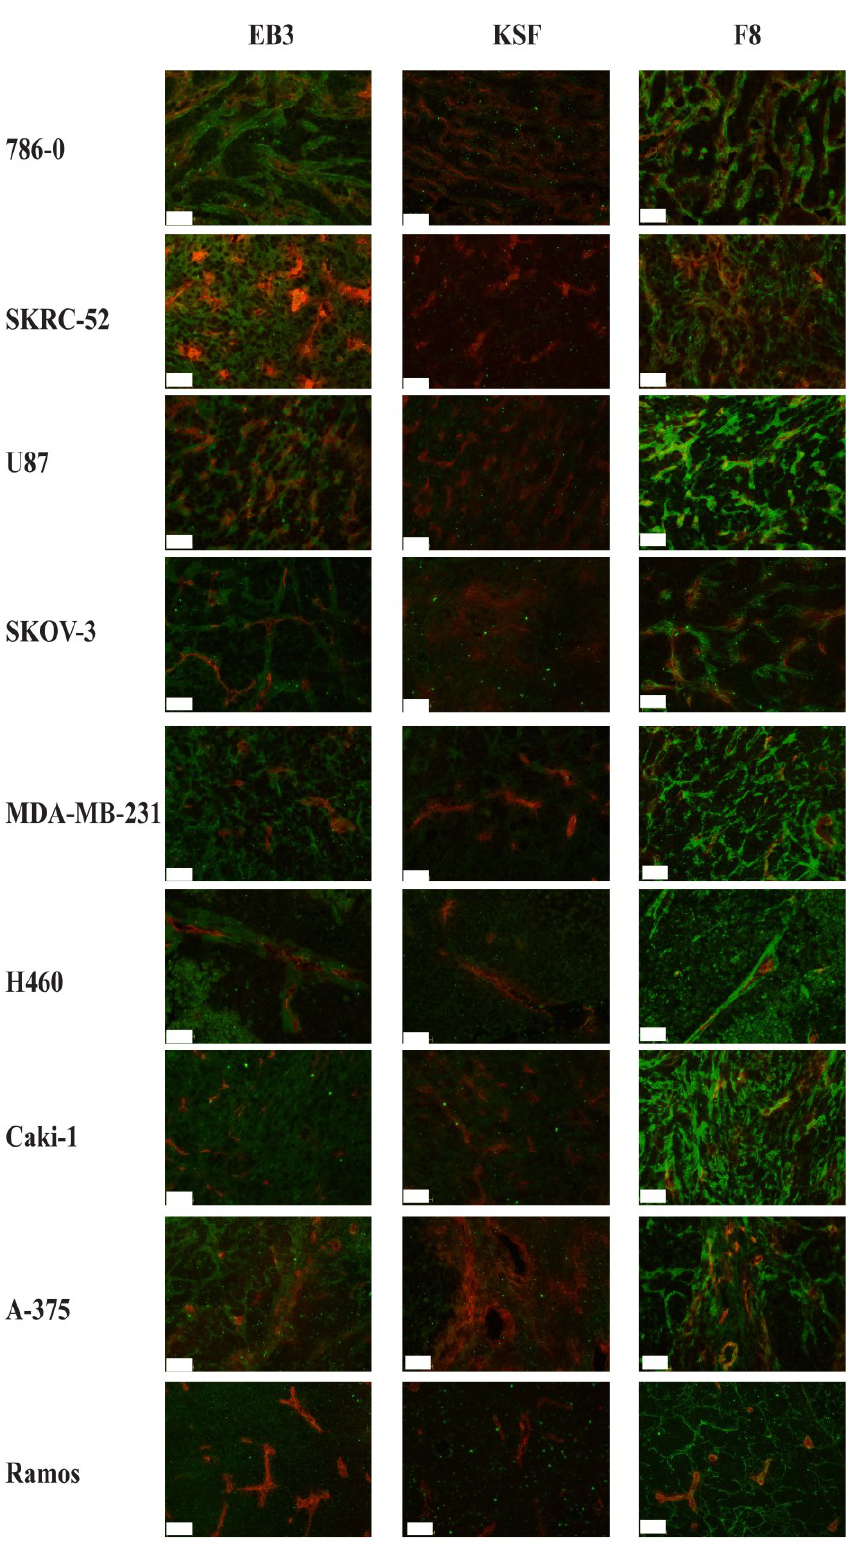
Figure 4. Immunofluorescence staining of human tumors xenografted in nude mice using SIP(KSF), SIP(EB3), SIP(F8) and anti-CD31 antibody. SIP antibodies are shown in green as they were detected using anti-human-IgE IgG antibody, which was then detected by Alexa Fluor 488 goat anti-rabbit IgG antibody. Endothelial cells of vessels are shown in red, as the anti-CD31 antibody was detected by donkey Alexa Fluor 594 anti-mouse IgG